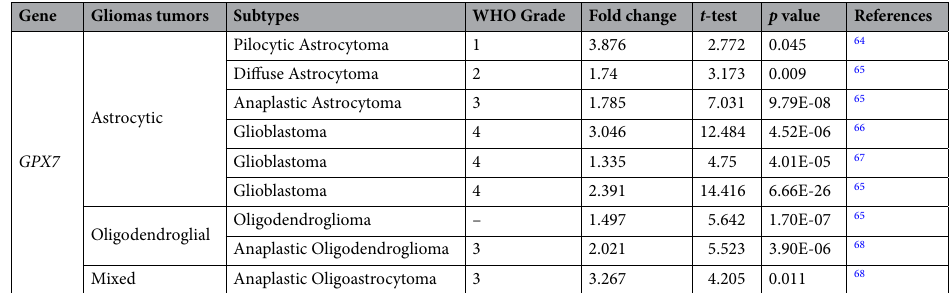
Table 1. Significant changes of GPX7 expression among different types of glioma tumors and normal brain tissues (Oncomine database).